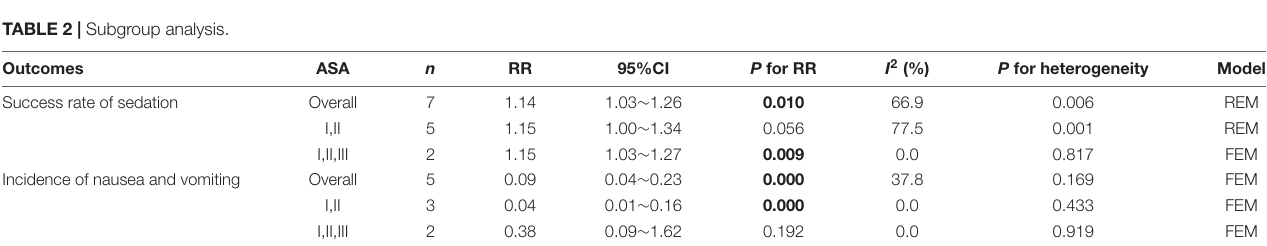
TABLE 2 | Subgroup